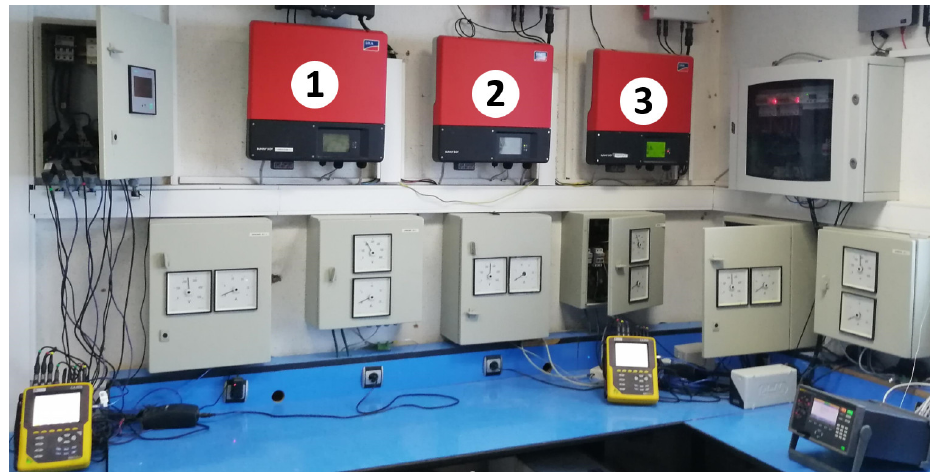
Figure 2. Picture of the grid connected rooftop PV system installed at CDER.